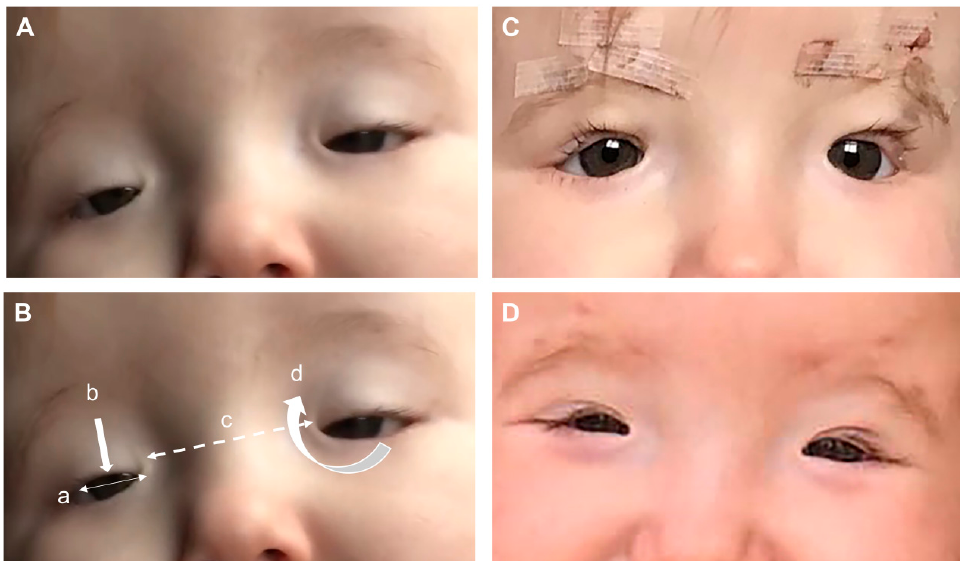
Figure 2. BPES patient with a heterozygous missense mutation in FOXL2 c.175T>G, p.(Tyr59Asp): ( A ) features seen at 4 months of age consisting of ( B ) four cardinal features: (a) blepharophimosis, (b) ptosis, (c) telecanthus, and (d) epicanthus inversus. ( C ) Bilateral correction of the ptosis at 12 months of age using a Supramid (artificial material) frontalis suspension technique and ( D ) eyelid position 6 months after the frontalis suspension operation.